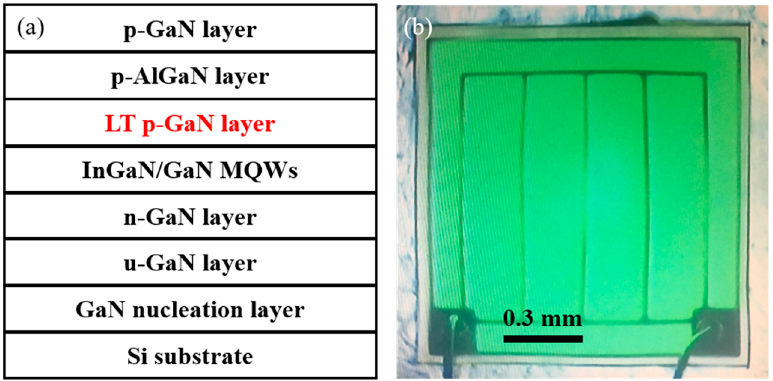
Figure 1. ( a ) Schematic diagram of green LED with a 20 nm-thick LT p-GaN layer. ( b ) Illuminated green LED chip at 300 K.